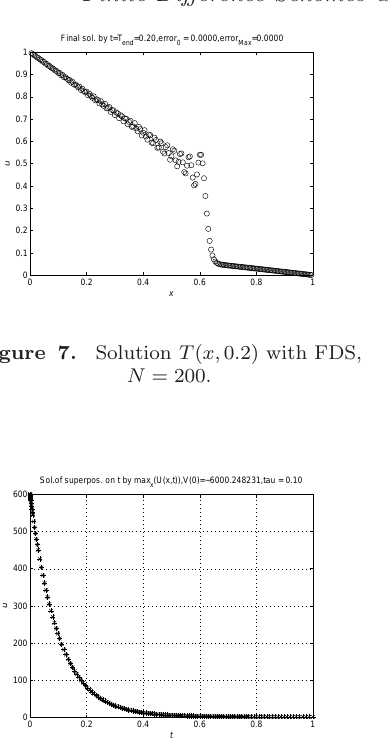
Figure 10. Solution depending on t , r for τ = 0 . 5, T 0 ( r ) = 600, V 0 ( r ) = − 1200 .